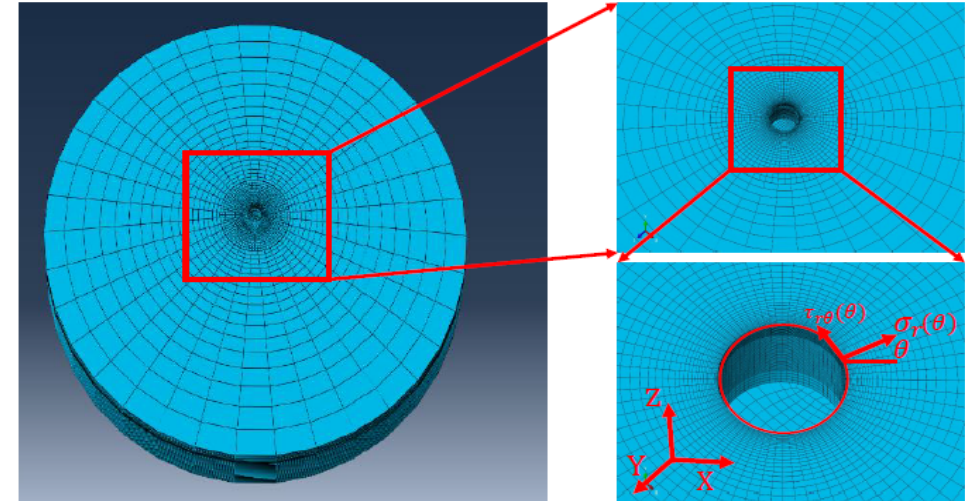
Figure 4. Calculation of calibration coefficients using an ABAQUS finite element analysis (FEA) model: local mesh refinement in the direct vicinity of the drilled hole and imposed loads at the hole boundary.